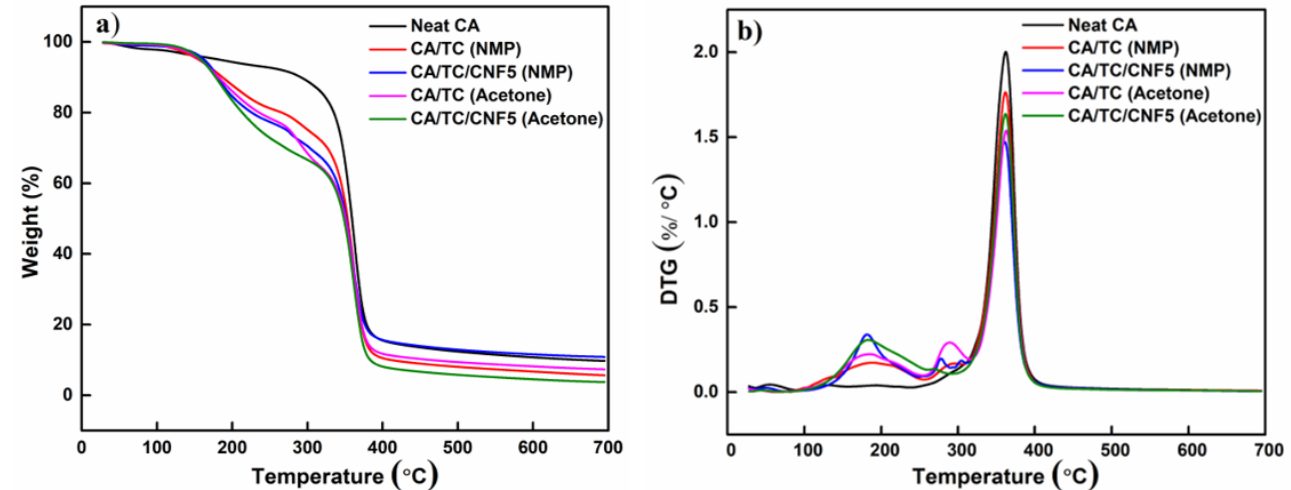
Figure 5. TGA ( a ) and DTG ( b ) graph of neat CA, CA/TC, and CA/TC/CNF5 in both acetone and NMP solvent.